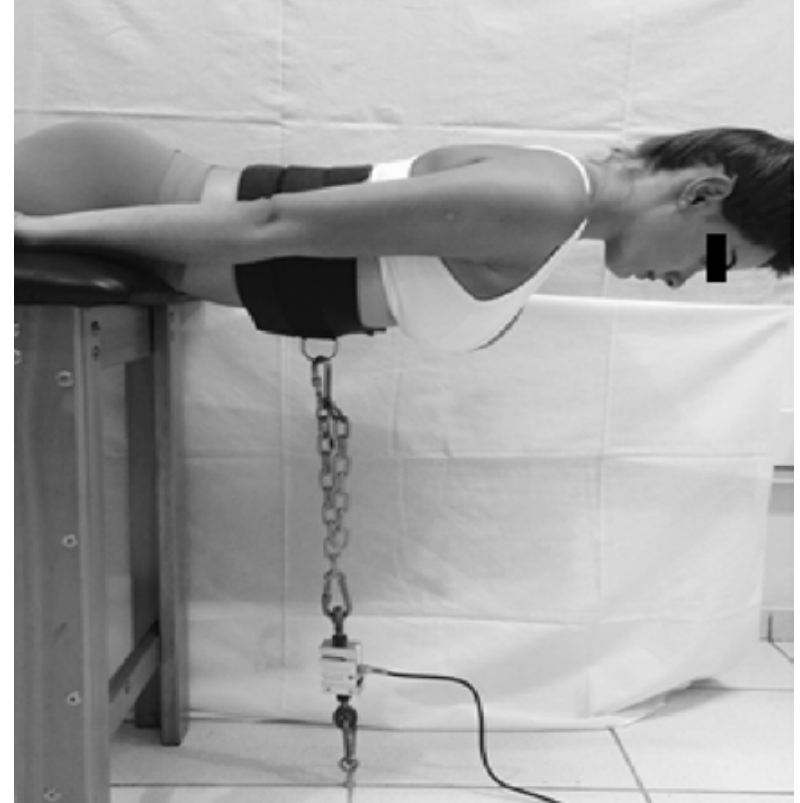
Figure 2. Illustrative photo to observe the positioning for MVIC test. Photo was authorized by the